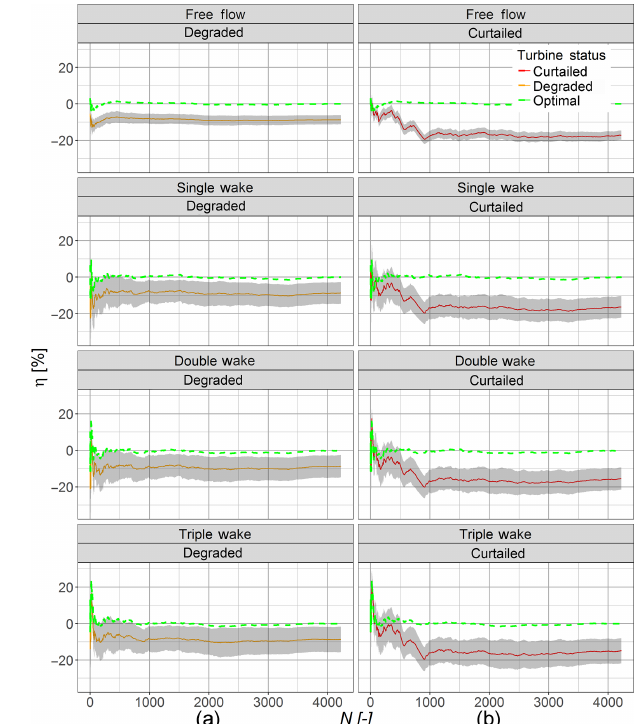
Figure 11. Underperformance detection for curtailment (b) and degradation (a) at turbines with different levels of wake influence. The displayed values represent the underperformance indicator η as a function of the number of values N . We highlight the first time of underperformance detection when the green dotted line is outside of the grey uncertainty bandwidth.